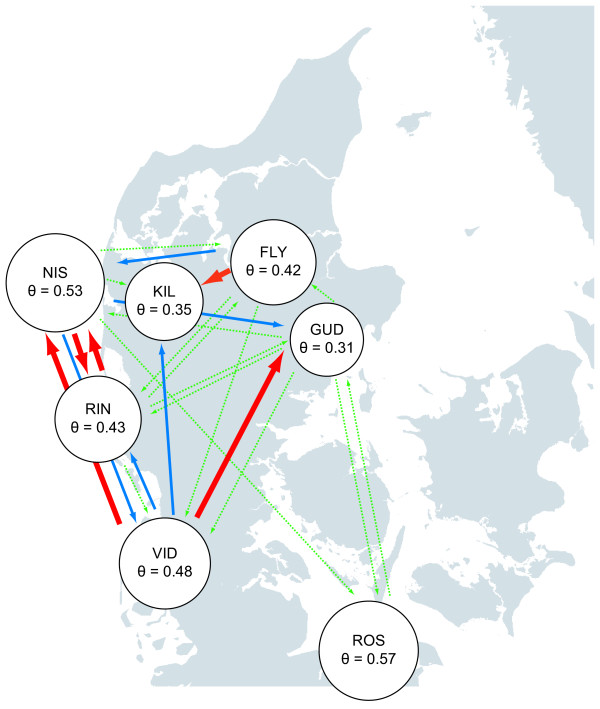
Historical effective population sizes and migration rates. Map with superimposed historical effective population size estimates (θ) of the sampled indigenous Coregonus populations. Gene flow estimates (M) and the direction of gene flow are indicated by arrows. Punctuated green arrows indicate 10 = M < 15, blue arrows indicate 15 = M < 20 and red arrows indicate M = 20. Estimates of M < 10 are not shown. See Additional file 2 for an overview of all θ and M values and their associated 95% confidence intervals. The analyses were conducted using the method and software MIGRATE 2.0.3 [58].